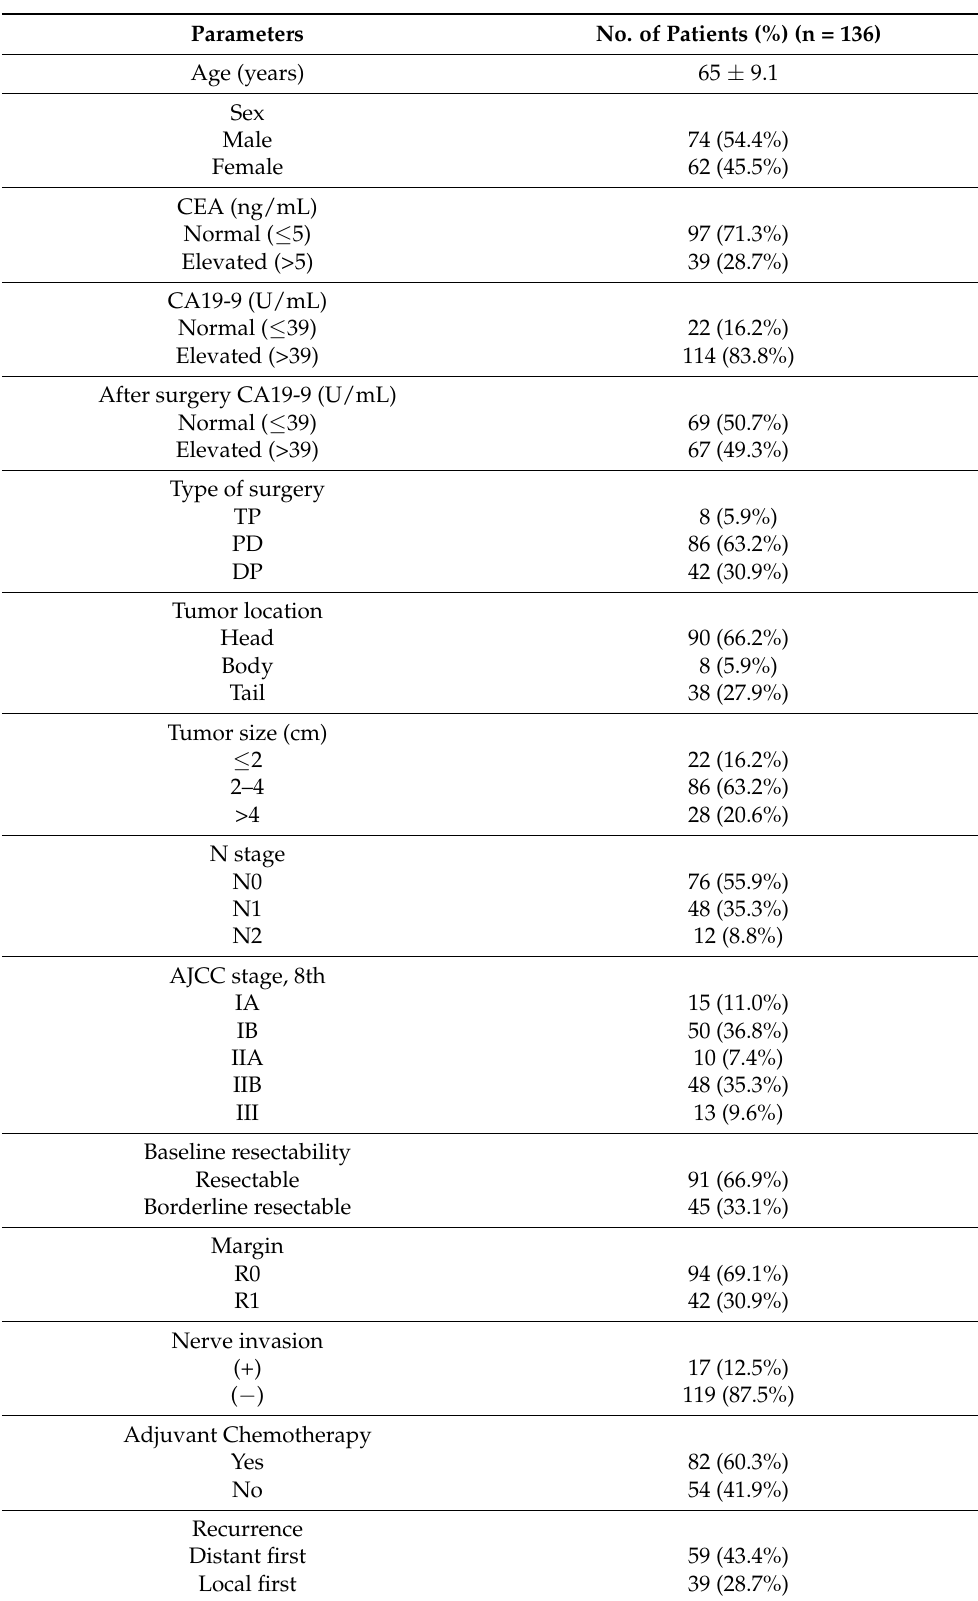
Table 1. Clinical–Pathologic and Radiologic Characteristics of 136 Patients with